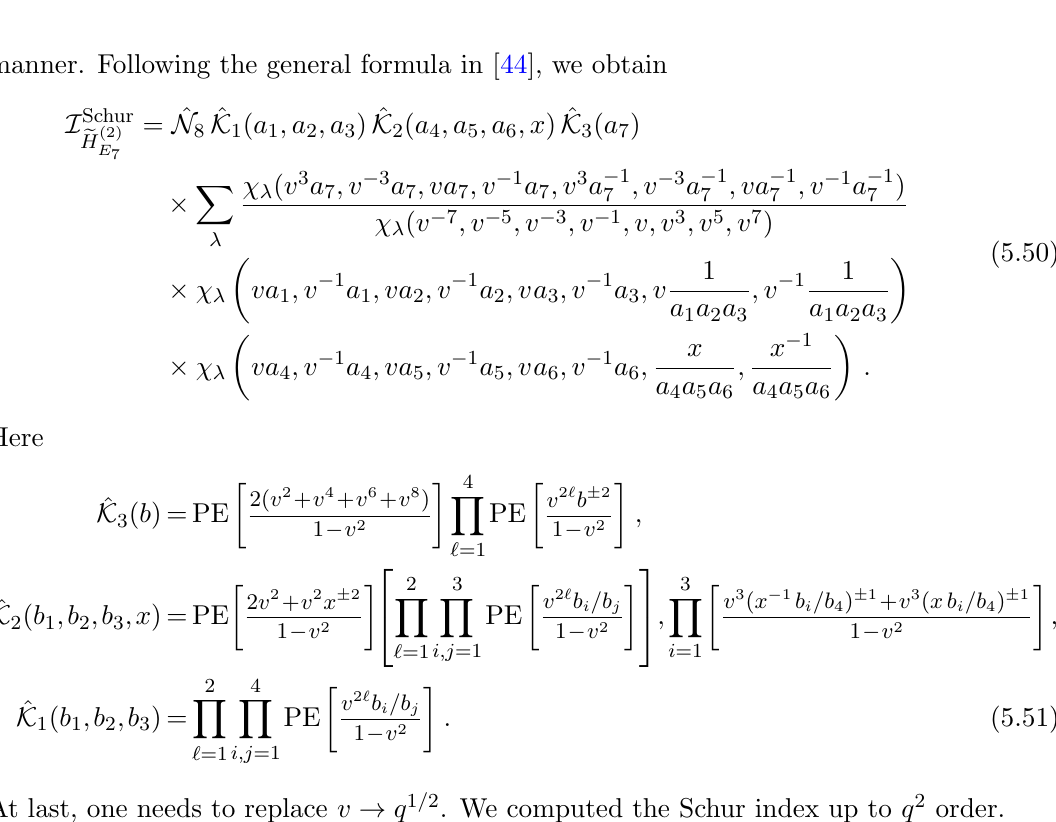
for the unre(cid:12)ned elliptic genus of two E 7 instanton. i;j